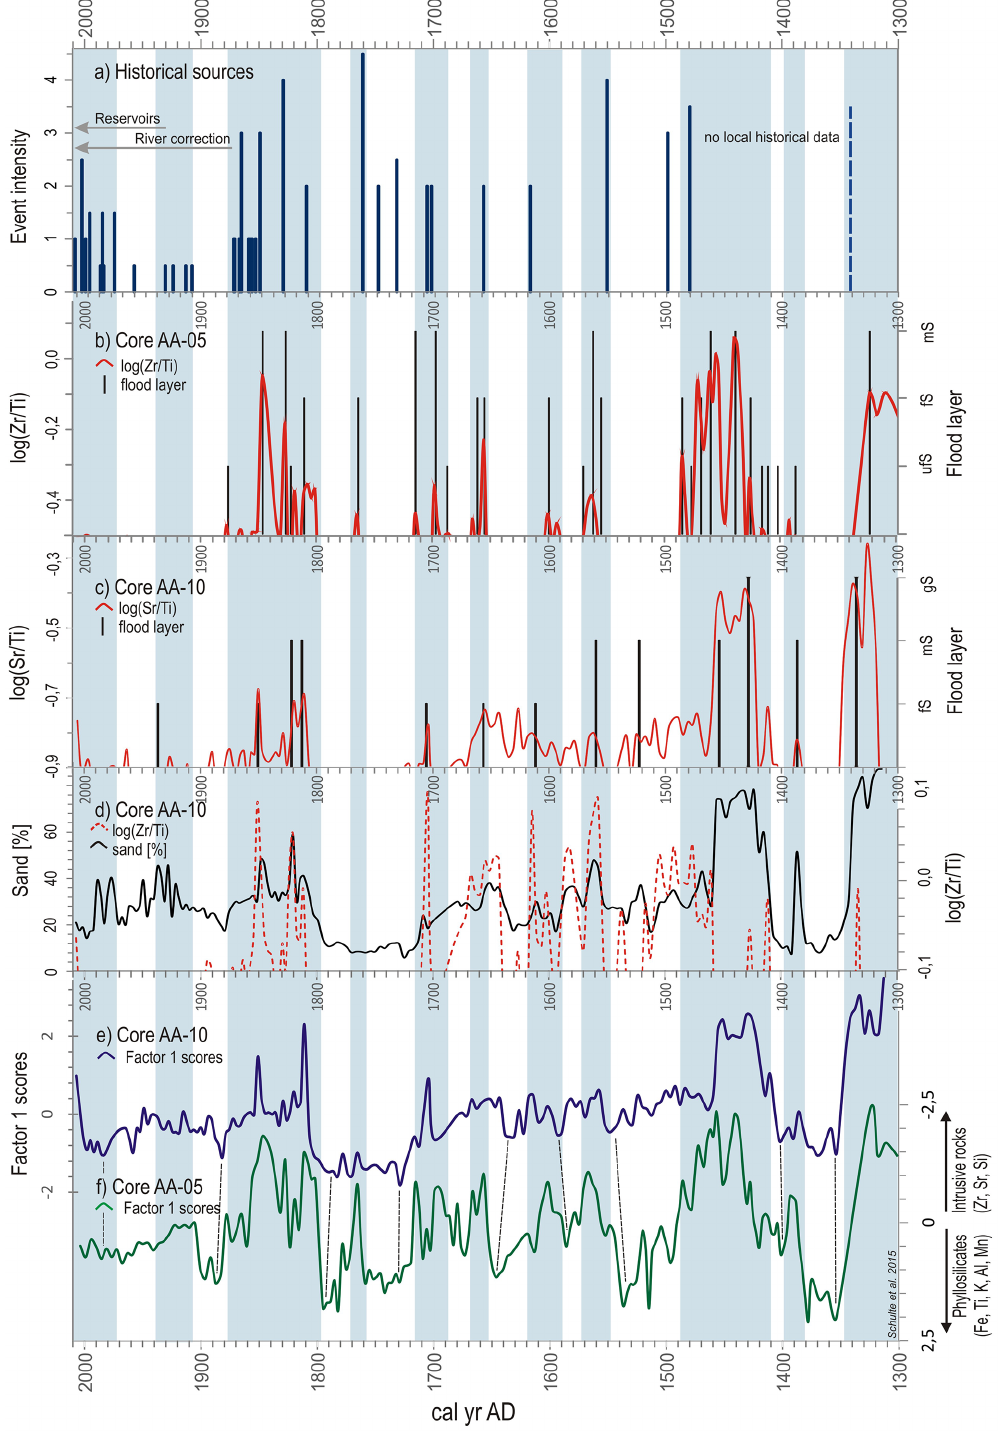
Figure 3. Chronostratigraphy of cores AA-05 and AA-10 and comparison with historical Aare floods in the Hasli Valley. Time series are plotted in calibrated calendar years (calyrAD). Each sample taken from cores at intervals of 1cm integrates 3.8 years. No filters were applied to the data series. (a) Flood data series reconstructed by historical sources (columns) and archaeological data (dashed column). (b) log(Zr / Ti) values > − 0.5 and coarse-grained flood layers (ufS: silty fine sand; fS: fine sand; mS: middle sand) of core AA-05. (c) log(Sr / Ti) values > − 0.9 and coarse-grained flood layers (fS: fine sand; mS: middle sand; gS: coarse sand) of core AA-10. (d) Sand fraction (630–2000µm) and log(Zr / Ti) values > − 0.1 of core AA-10. (e, f) factor 1 scores of chemical composition of core AA-10 and AA-05 samples